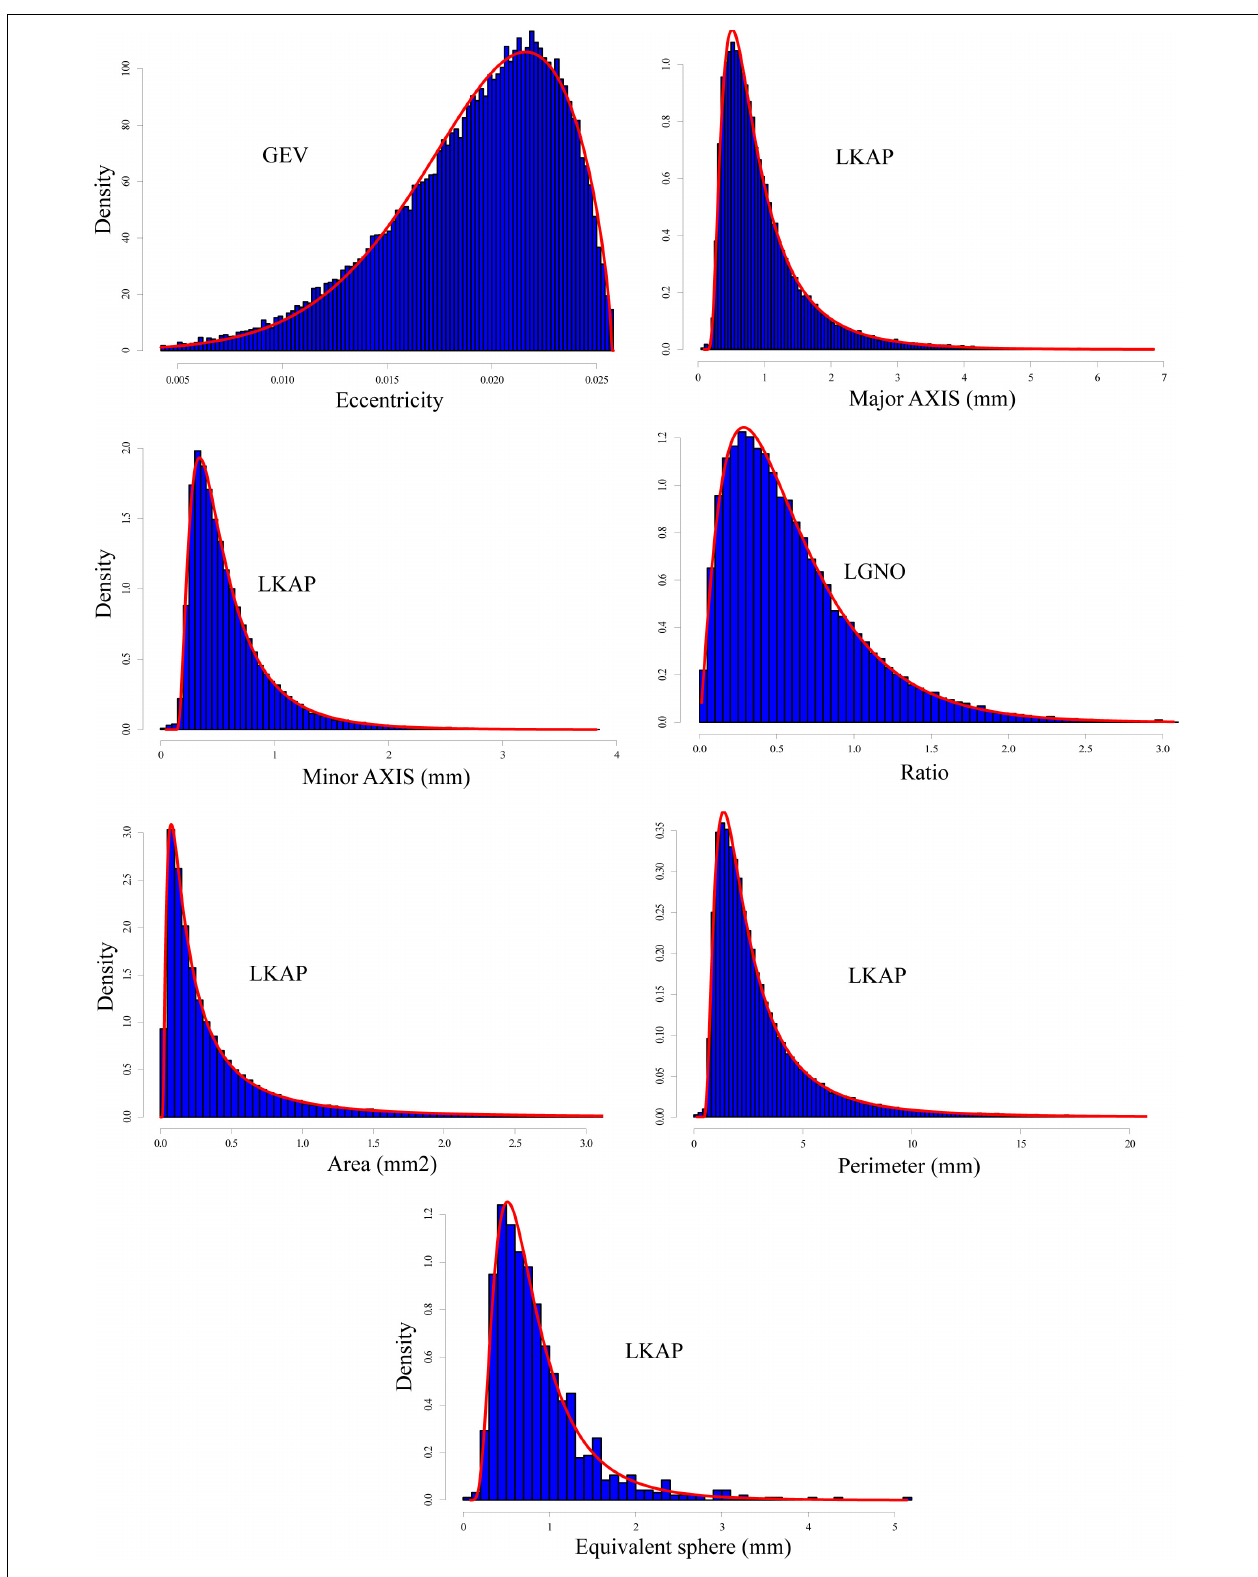
FIGURE 4 | Same as Figure 3 but for all snow grains classified as “rounded” with a total of 50,633 grains.